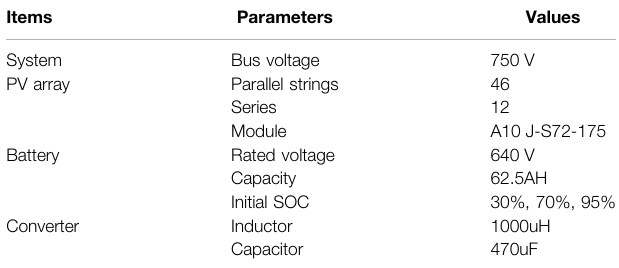
TABLE 1 | Key parameters in the simulation.